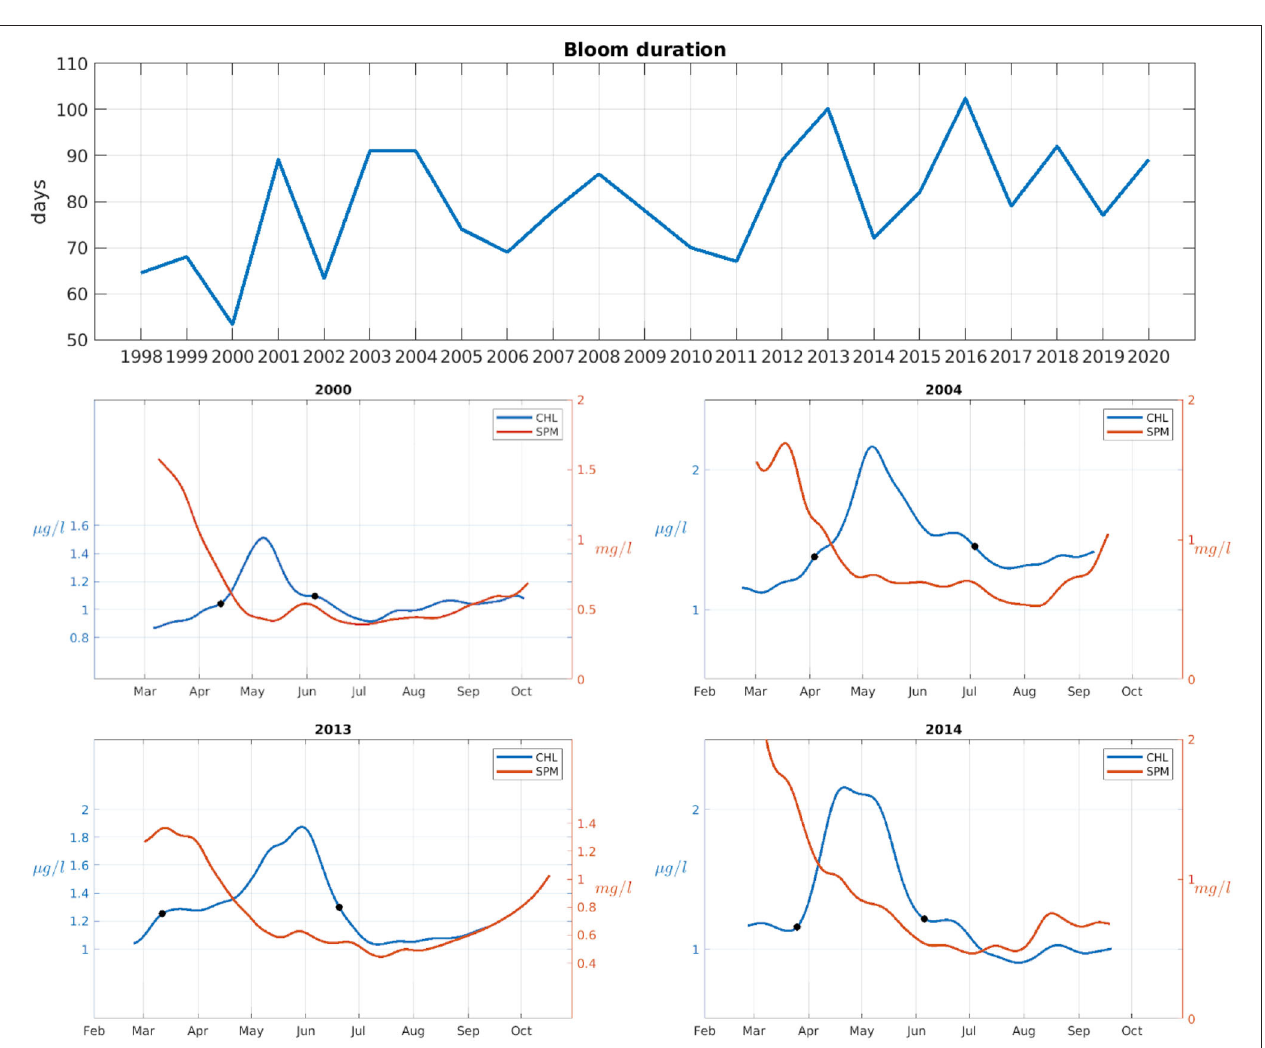
FIGURE 11 | Top : spring bloom duration in days for each year of the study. Middle and bottom rows, the domain-averaged CHL (in blue) and SPM (in red) with a 30-day low pass filter. The dates at which the bloom starts and ends (black dots) as determined by the median threshold method. Years 2000, 2004, 2013, and 2014 are given as